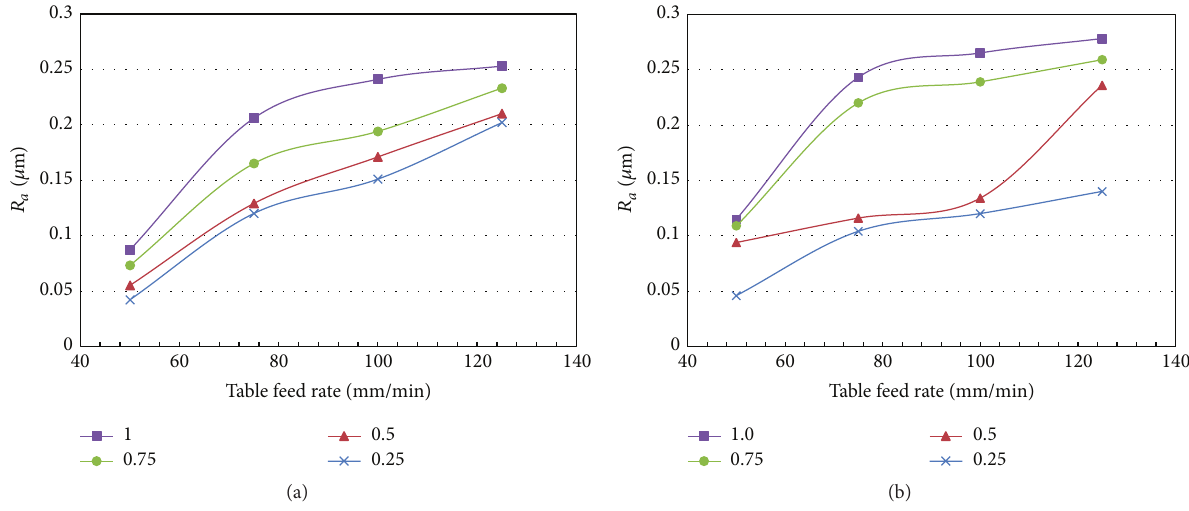
Figure 3: The effect of table feed rate on 𝑅 𝑎 for different depth of cuts (mm) at 500 rpm in (a) and 1000 rpm in (b).